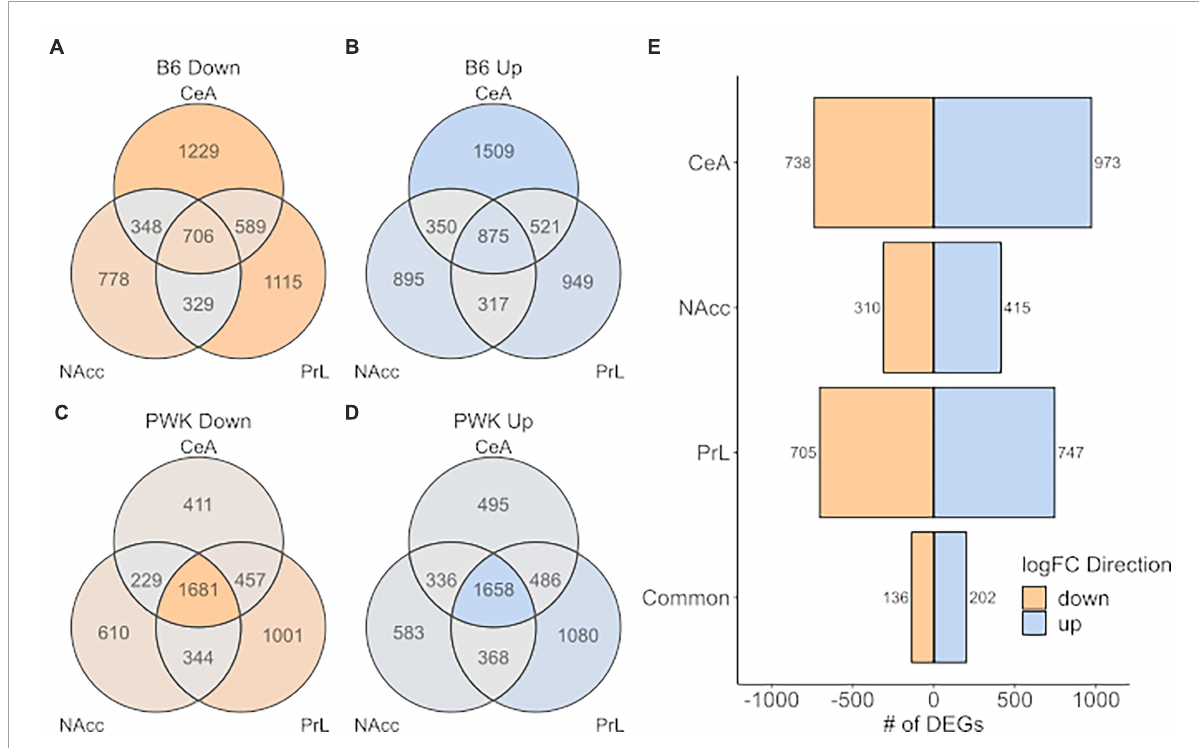
FIGURE6 High preference strains vs. low preference strains. DEGs found for B6 and PWK compared the average expression of the low preference strains across strain and brain region (liberal selection criteria; Low_average: (AJ + CAST + NOD + NZO + S129 + WSB)/6). (A,B) Identified DEGs across individual brain regions for B6. (C,D) Identified DEGs across brain regions for PWK. (E) Unique DEGs commonly different between PWK and B6 and the low_average for each brain region and in all three brain regions (common). Two hundred and thirty-eight (136 down- and 202 up-expressed) DEGs are found to be commonly different between B6 and PWK and the low_average across all three brain regions, more than 10x the number identified using unique DEGs (see Figure 5